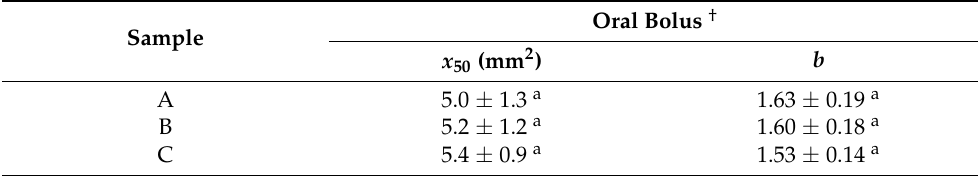
Table 1. Estimated Rosin-Rammler parameters (Equation (2)) of “all” black bean particles from sam- ples A (PEF and thermally processed without CaCl 2 addition), B (PEF and thermally processed with CaCl 2 addition), and C (No PEF, thermally processed with CaCl 2 ) after in vivo human mastication (average of 17